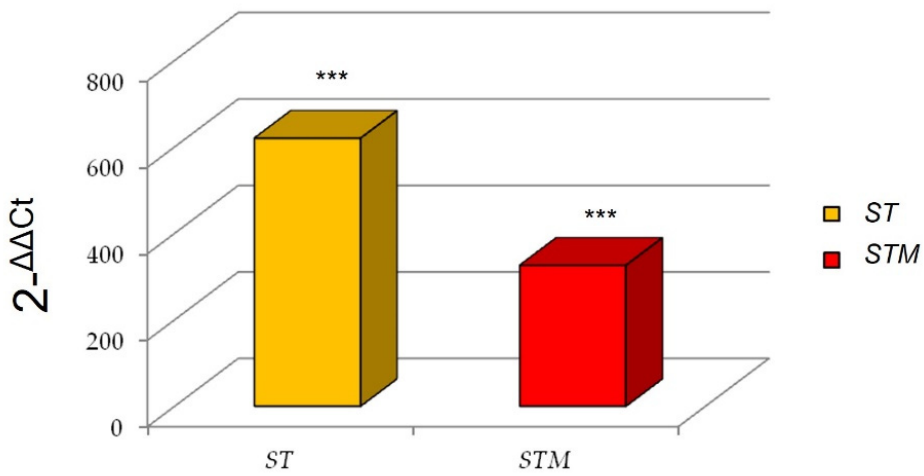
Figure 2. IL6 expression after immunostimulation of CF33 line consequent to ST or STM exposition. Significance of expression data was calculated by t -test. *** p < 0.0001 respect to control cells.